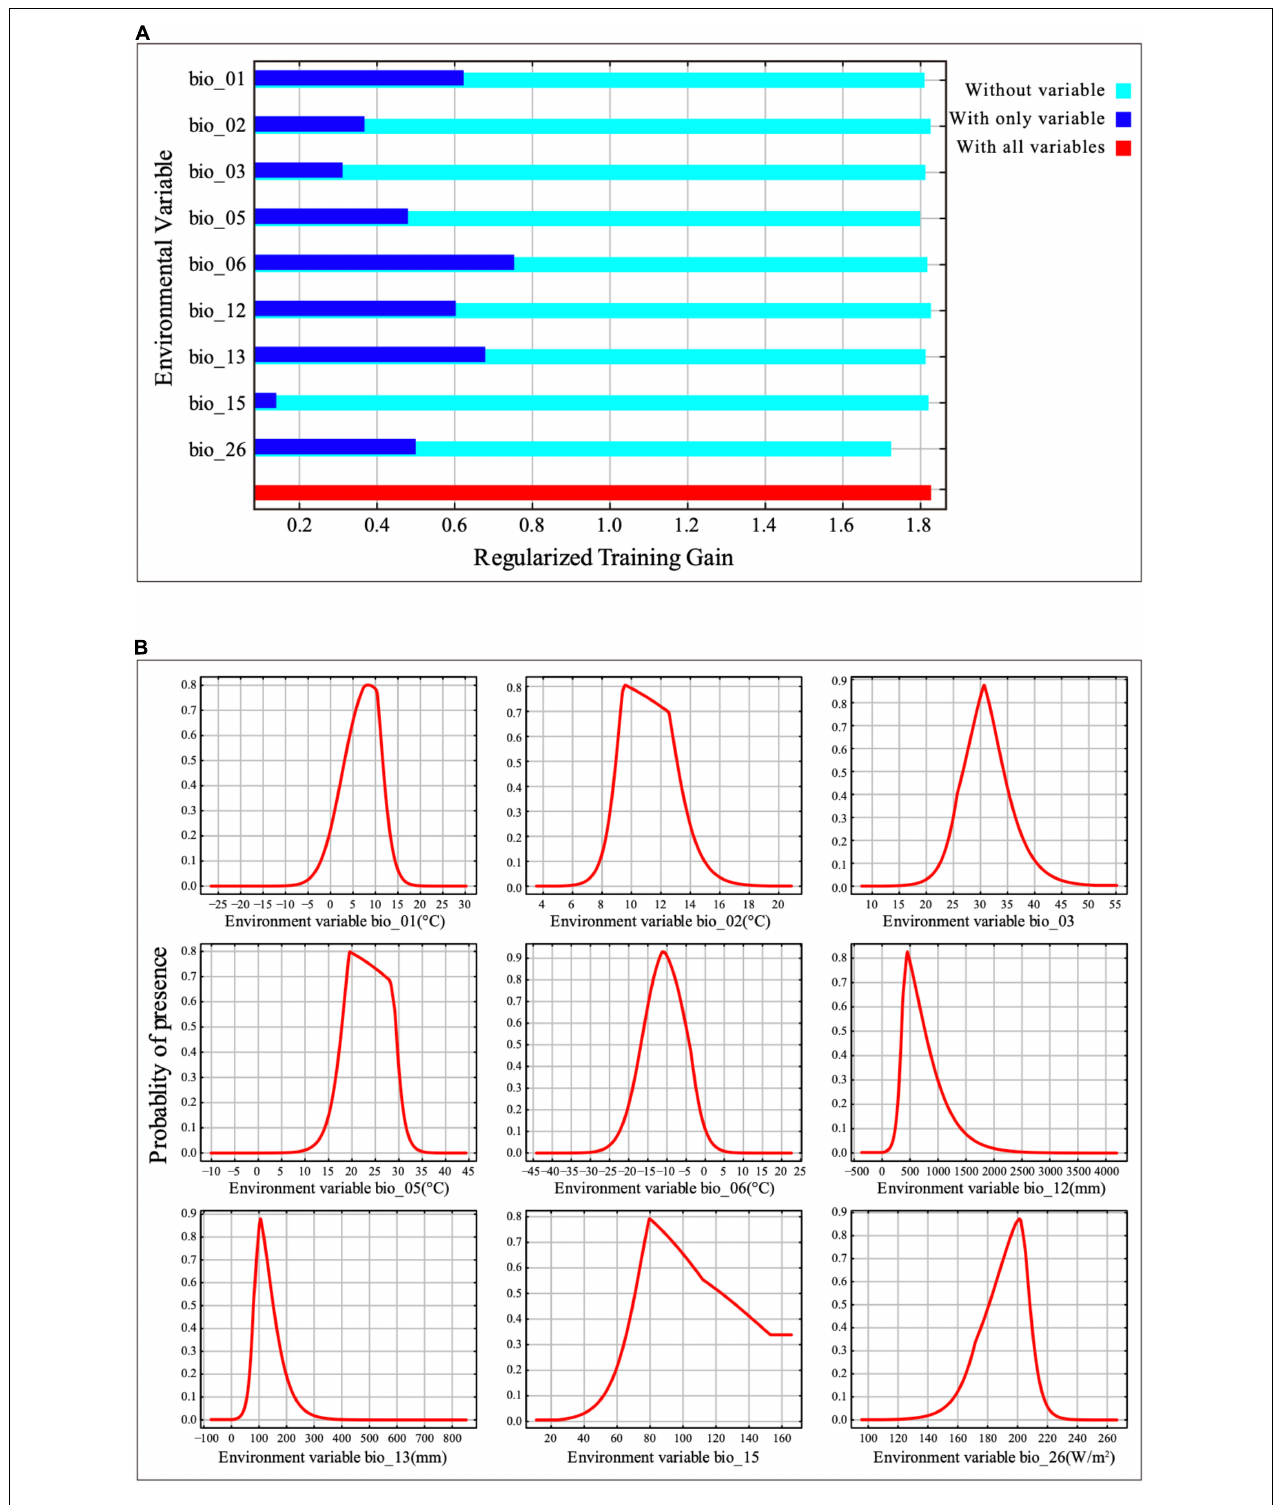
FIGURE 2 | Contribution and response curves of selected bioclimatic/environmental variables. (A) Jackknife test of variable importance in the distribution of B. pyrosoma. (B) Response curves of the nine variables.